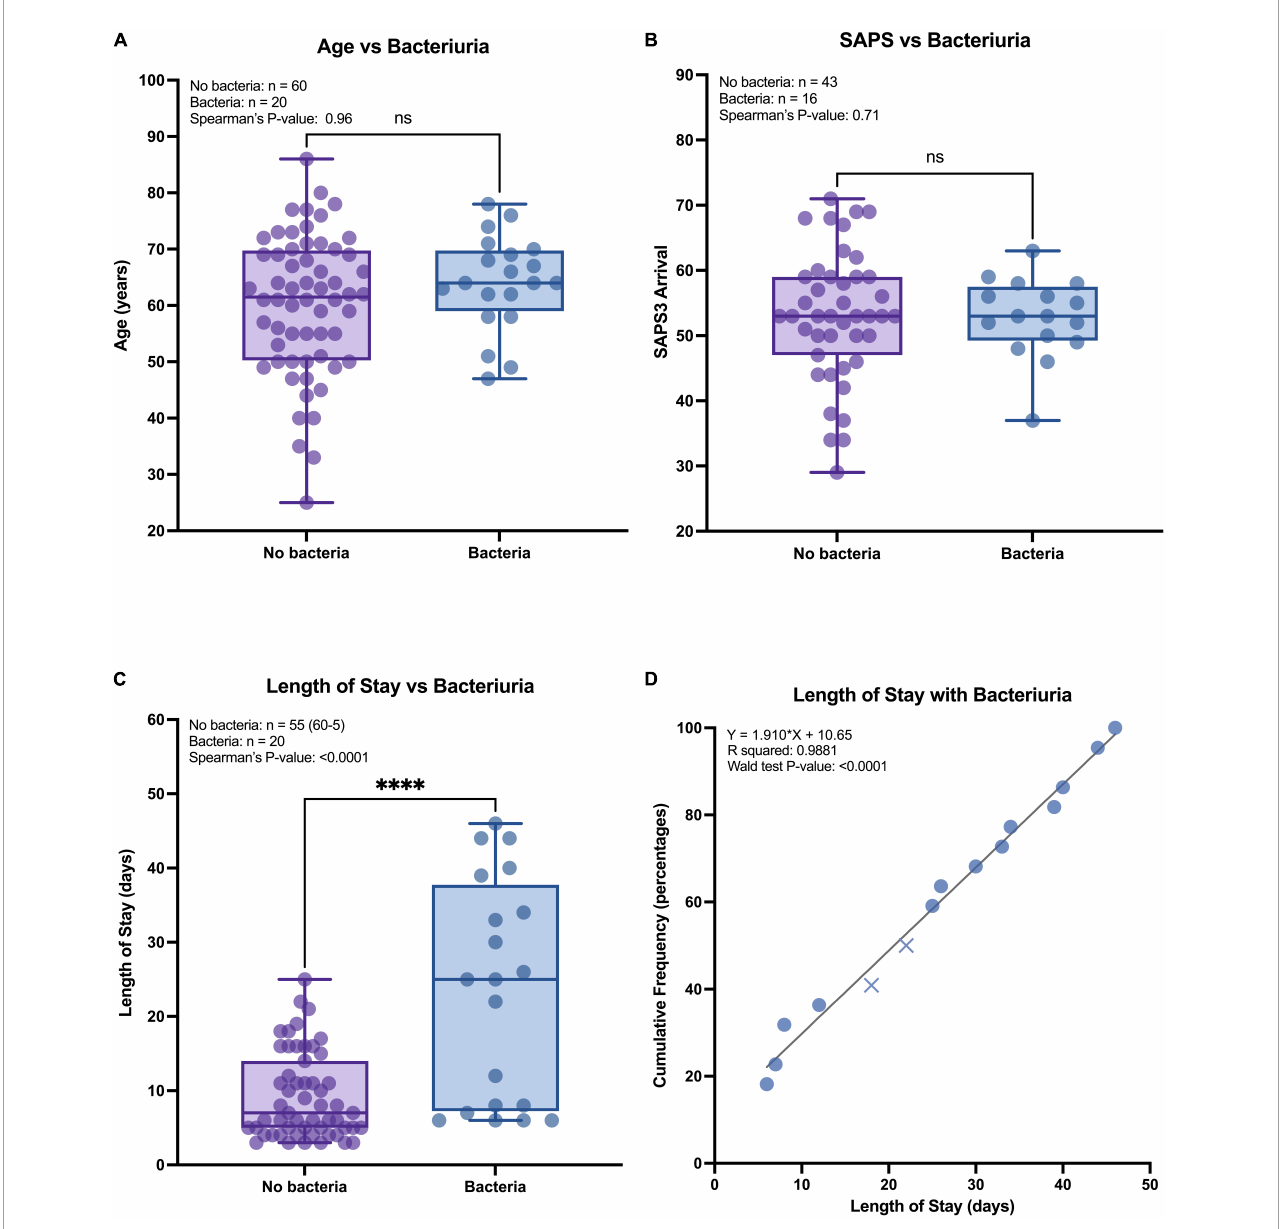
FIGURE2 Continuous parameters and risk of bacteriuria. (A–C) All patients were grouped by urine colonization, no (purple) and yes (blue), compared against three continuous parameters. The comparison was measured with a two-tailed t -test (illustration) and Spearman’s rank correlation (top left text). **** P < 0.0001. (D) Patients with urine study samples were sorted by cumulative frequency against the length of stay (LOS) and tested against a linear regression model (significance measured with the likelihood test and Wald test). Pattern indicate patients that survived (circle) and patients that died (cross).